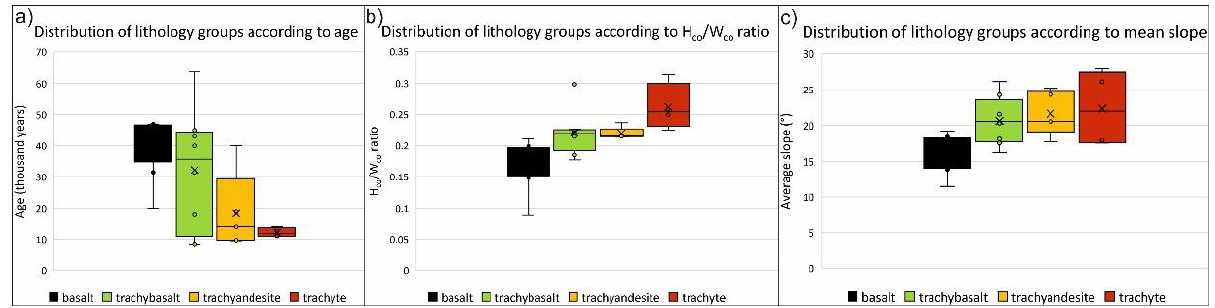
Figure 7. Distribution of lithology groups according to ( a ) ages, ( b ) H co / W co , and ( c ) mean slope (black: basalt, green: trachybasalt, yellow: trachyandesite, red: trachyte).